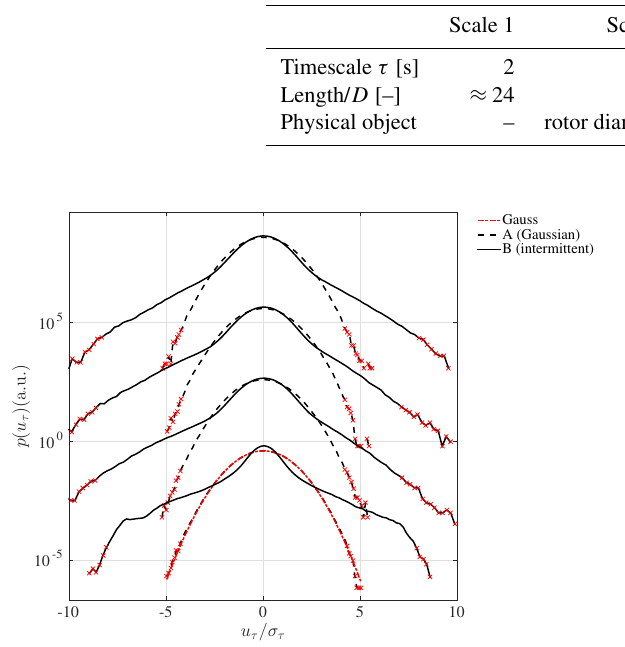
Figure 8. p ( F τ ) of the turbine’s thrust force (in main flow direc- tion) exposed to the inflow conditions A (dashed) and B (solid) for τ = { 67 , 80 ms , 2 s } from top to bottom. The different scales are shifted vertically for